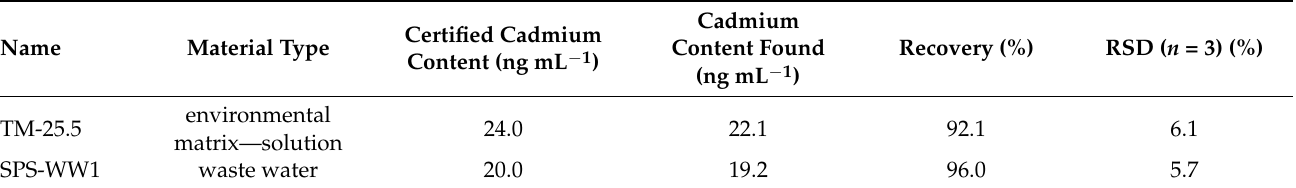
Table 2. Analysis of certified reference materials TM-25.5 Environmental Matrix Reference Material and SPS-WW1 Waste Water. The samples were examined using the standard addition